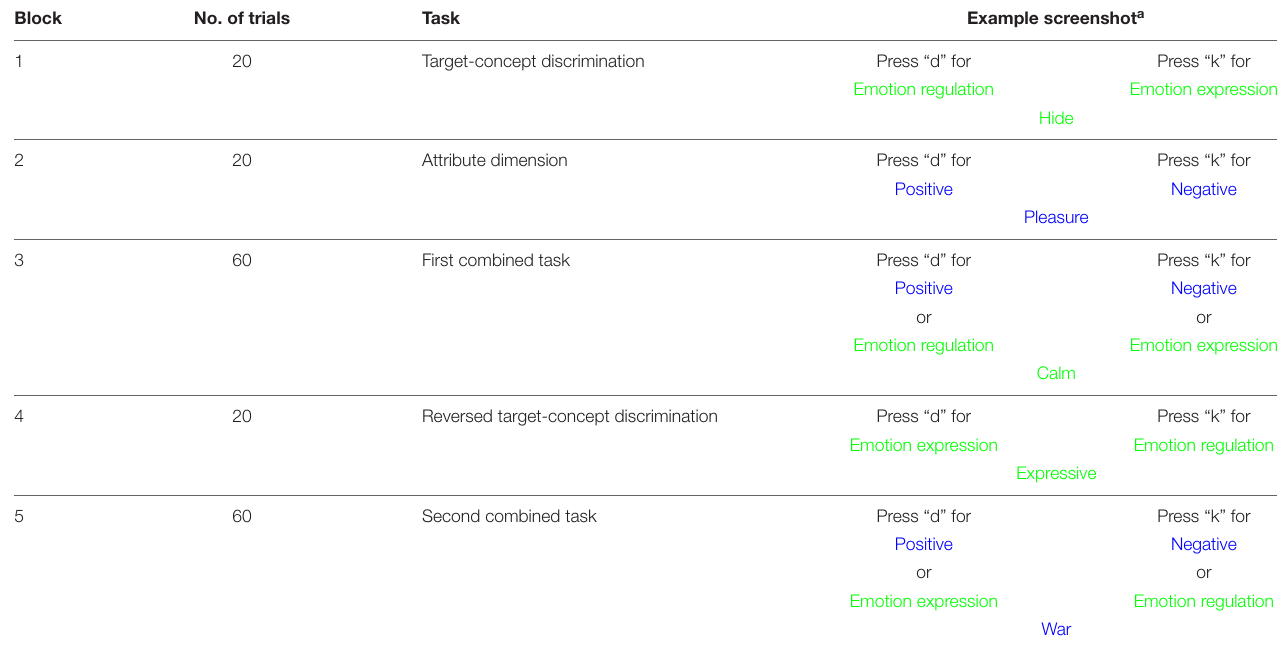
a Green color refers to target-concept words. Blue color refers to attribute